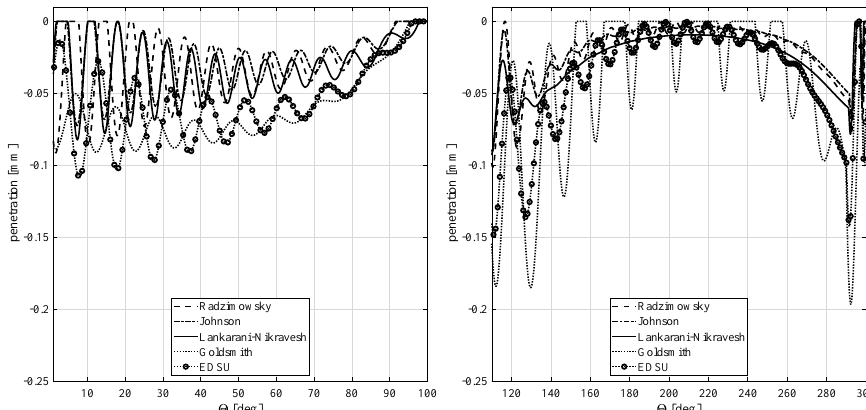
Figure 13. Detail of penetration comparison.